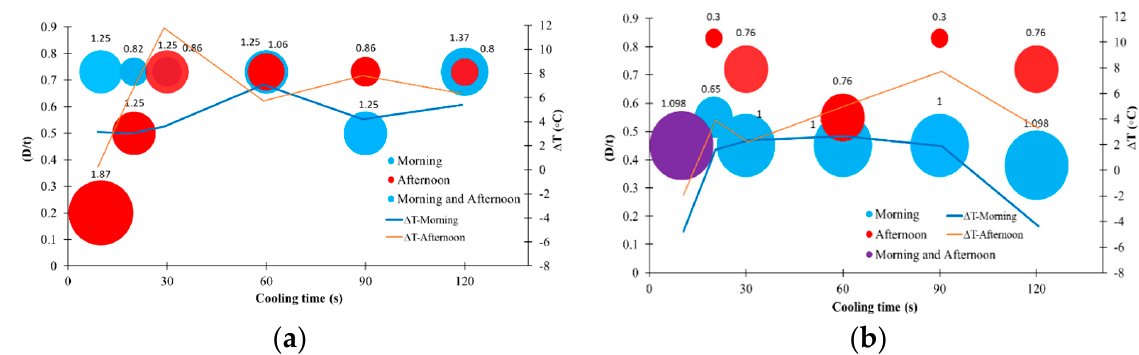
Figure 8. Characterization of the defects detected when the heating time was 20 s on the ( a ) east side and ( b ) west side.